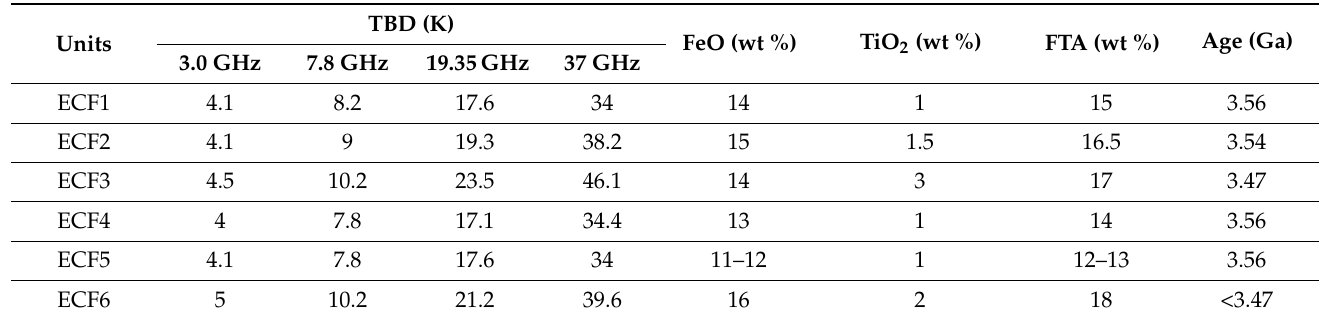
Table 3. The SCREP-based FeO, TiO 2 , and FTA values mapped by Kramer et al. [2] and the four- channel TBDs of the ECF1, ECF2, ECF3, ECF4, ECF5, and ECF6 units.